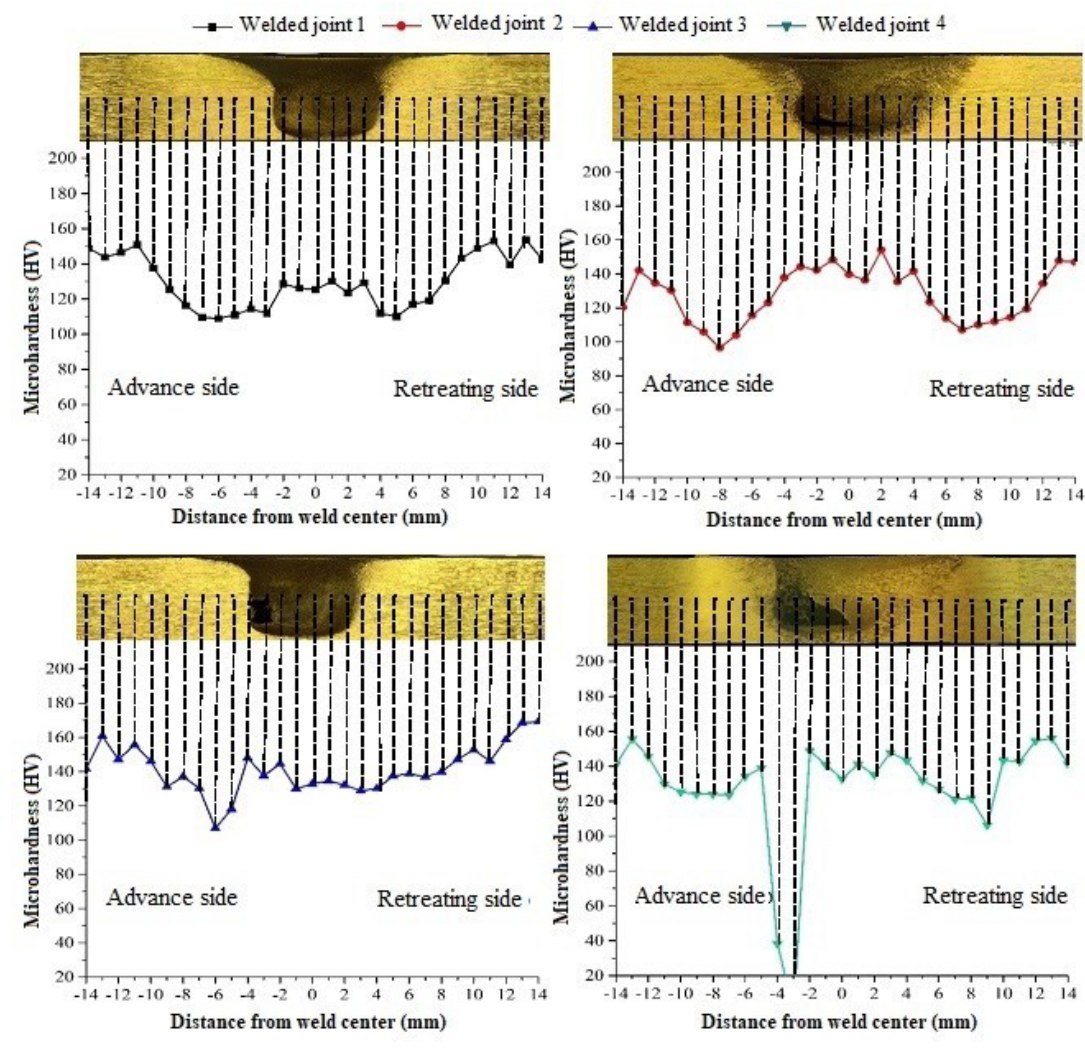
Figure 10. Hardness distribution in the cross section of welded joints.